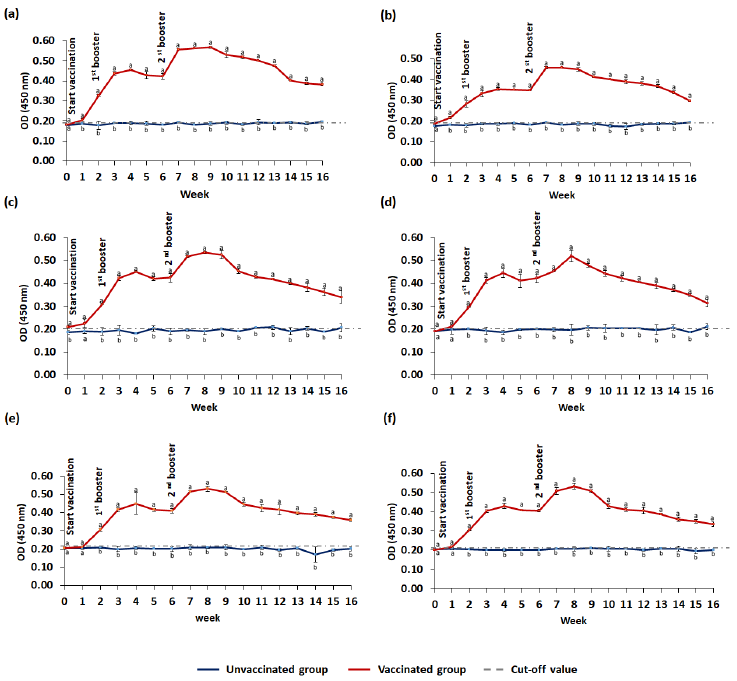
Figure 9. Specific IgM levels against S. iniae and A. veronii in red hybrid tilapia. The blue line represents the unvaccinated (control) group, and the red line represents the vaccinated group. Serum IgM levels against S. iniae ( a ) and against A. veronii ( b ). Gut lavage IgM levels against S. iniae ( c ) and against A. veronii ( d ). IgM levels in skin mucus against S. iniae ( e ) and against A. veronii ( f ). The number of fish used per time point ( n = 6). Values are mean ± standard deviation in triplicate sam ‐ ples. One ‐ way ANOVA was performed with the Tukey–Kramer post hoc test to compare IgM levels between vaccinated and unvaccinated groups. Means with different superscripts (a–b) differ signif ‐ icantly at p ≤ 0.05 (one ‐ way ANOVA) significance level. 4. Discussion Streptococcosis and MAS are diseases that cause high mortality in aquaculture. Co ‐ infections have also been reported, leading to high economic losses [6,11,13,28]. Antibiot ‐ ics have been used to control disease outbreaks, but antibiotics might harm the environ ‐ ment and other living organisms [42,43]. Vaccination is considered a better alternative [24,44–46], and an oral delivery method offers more practicality [36]. Nevertheless, vac ‐ cines against streptococcosis and MAS using injection ad immersion delivery methods have been developed, although these target a single infection and are less practical [47]. Mortality in cultured fish is not caused by a single infection; therefore, developing a biva ‐ lent or cross ‐ protective vaccine provides the advantage of protecting against multiple in ‐ fections by different pathogens. This simultaneously provides practical ease of application and reduction in vaccination costs. Streptococcus agalactiae has been identified as the most common bacterium that causes streptococcosis, although S. iniea has also been implicated in outbreaks of streptococcosis [25,41,48–51]. In addition to streptococcosis, MAS, which is caused mainly by A. hydroph ‐ ila , is responsible for great economic losses in the aquaculture sector [52]. The present study used a feed ‐ based bivalent vaccine containing formalin ‐ killed S. agalactiae and A. hydrophila that was supplemented with 10% palm oil before being incorporated into fish